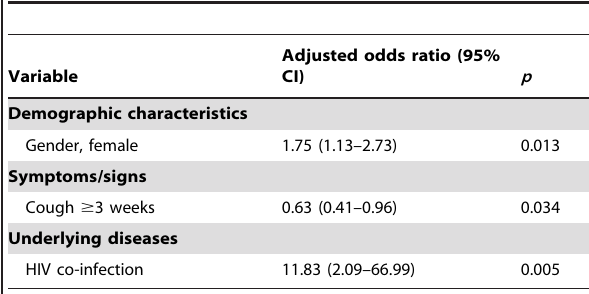
Table 4. Multivariate analysis of factors associated with concurrent EPTB in patients with PTB from the KMUH